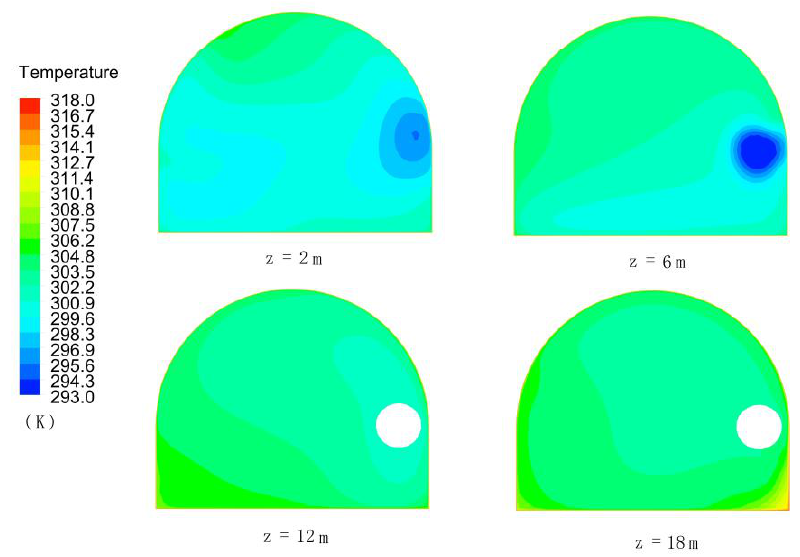
Figure 9. Model 3 section temperature distribution.